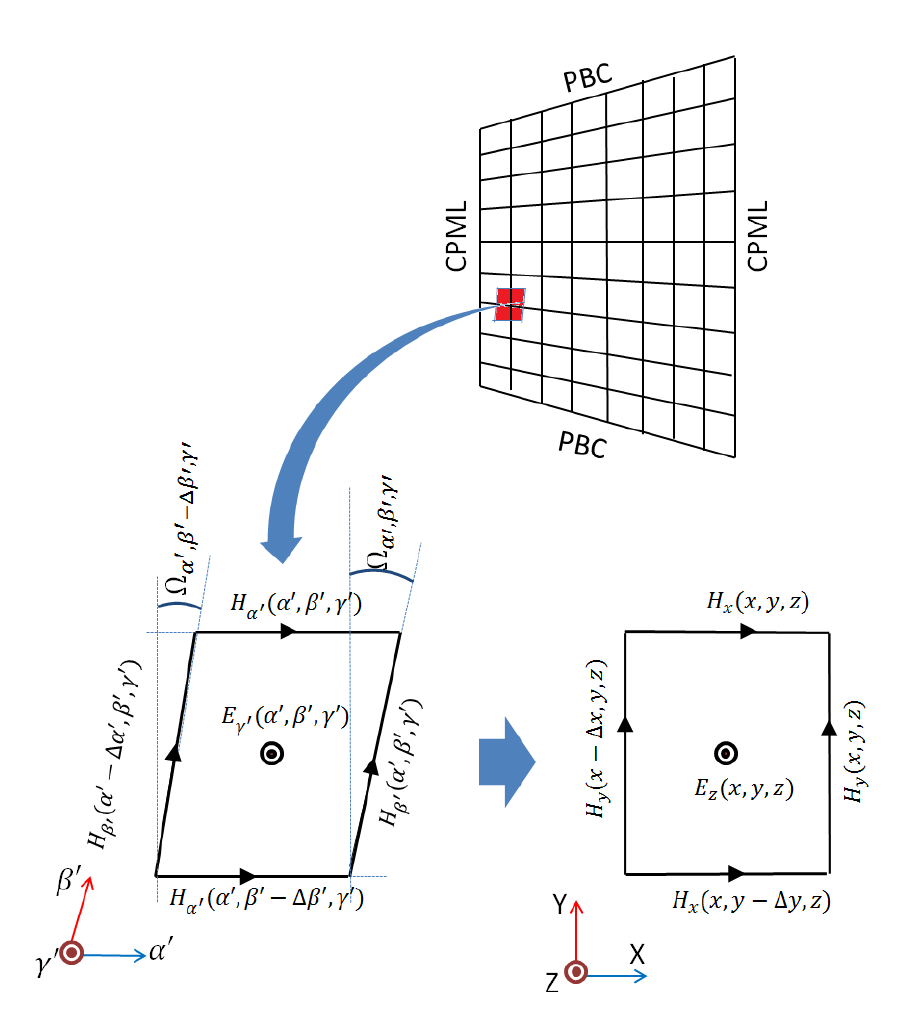
Figure 6. Illustration of the process of transforming the magnetic field component in the nonorthogonal grid into the magnetic field in the orthogonal